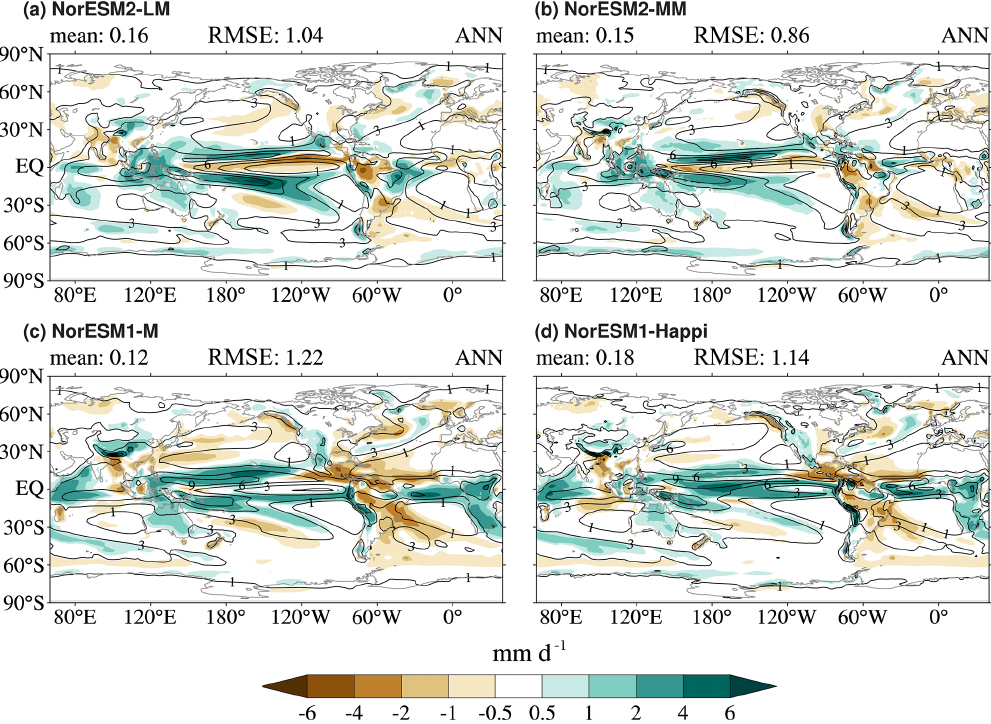
Figure 19. Annual-mean ensemble-mean model bias for total precipitation rate (colours) shown with the present-day model climatology (solid black contours; values from 1 by 2mmd − 1 ) from NorESM2-LM ( a ; years 1980–2009), NorESM2-MM ( b ; years 1980–2009), NorESM1-M ( c ; years 1976–2005), and NorESM1-Happi ( d ; years 1976–2005). Three ensemble members are used for all model ver- sions. The bias is taken with respect to GPCP (years 1979–2008 for NorESM1-M/Happi and 1980–2009 for NorESM2-LM/MM). Units are mmd − 1